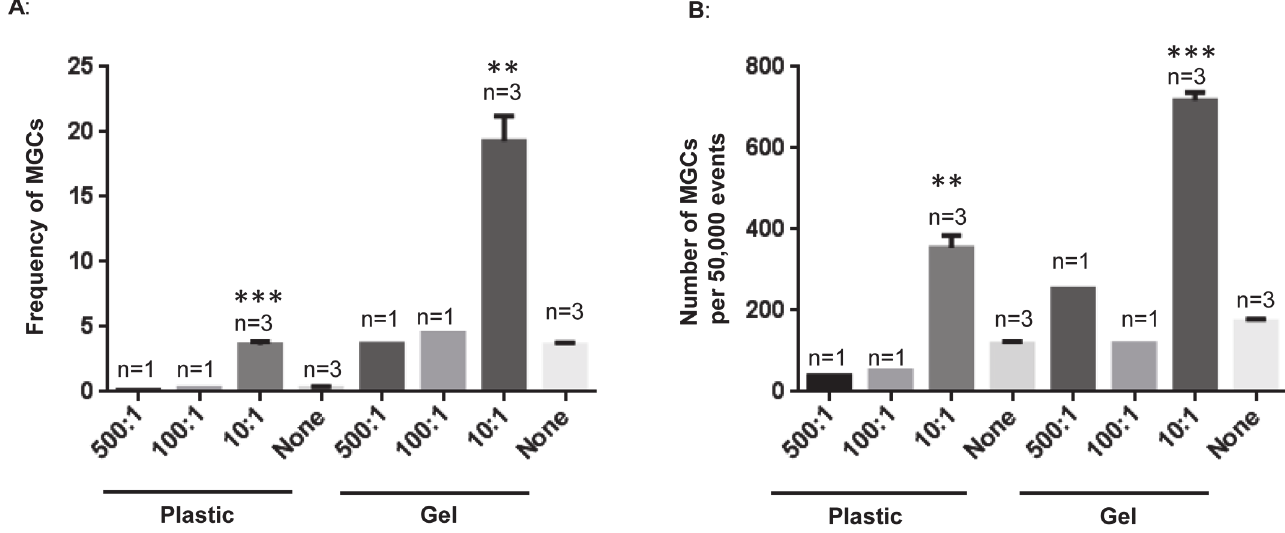
Fig 3. Higher frequency and number of MGC formation at a 10:1 ratio compared to 100:1 and 500:1 ratios in 3-D model. Particles were added at the time of gel polymerization at a ratio of 500:1, 100:1, or 10:1 or without particles (0:1) to PBMCs, as described previously, and incubated for 2 weeks. Cells were harvested with collagenase treatment, fixed and permeabilized using BD cytofix/ perm buffer, and stained with propidium iodide before acquisition on a flow cytometer. Frequency of MGCs per 50,000 events is represented in A, while the MGCs number is represented in B. The results are represented as mean +/- S.E. of three independent experiments, shown as n = 3 for “ 0:1 ” and “ 10:1 ” . Asterisks indicate statistically significant MGCs increase in particles exposed cells at 10:1 compared with those untreated cells, none. ( ** = p < 0.005; *** = p <